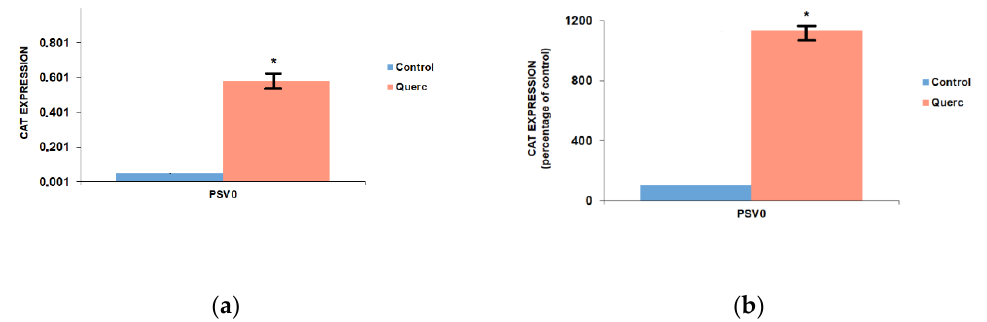
Figure 2. E ff ects of 10 µ M quercetin on CAT (Chloramphenicol acetyltransferase) expression in FRTL-5 cells transiently transfected with pSV0-CAT vector. ( a ) CAT protein concentrations are normalized with respect to total cell protein concentrations and represent the means ± S.D. of three separate experiments; ( b ) Same data expressed relative to the control vector (set to 100%). Control, cells treated with the control vehicle (0.1% ethanol); Querc, cells treated with 10 µ M quercetin. * p < 0.05 versus relevant control.